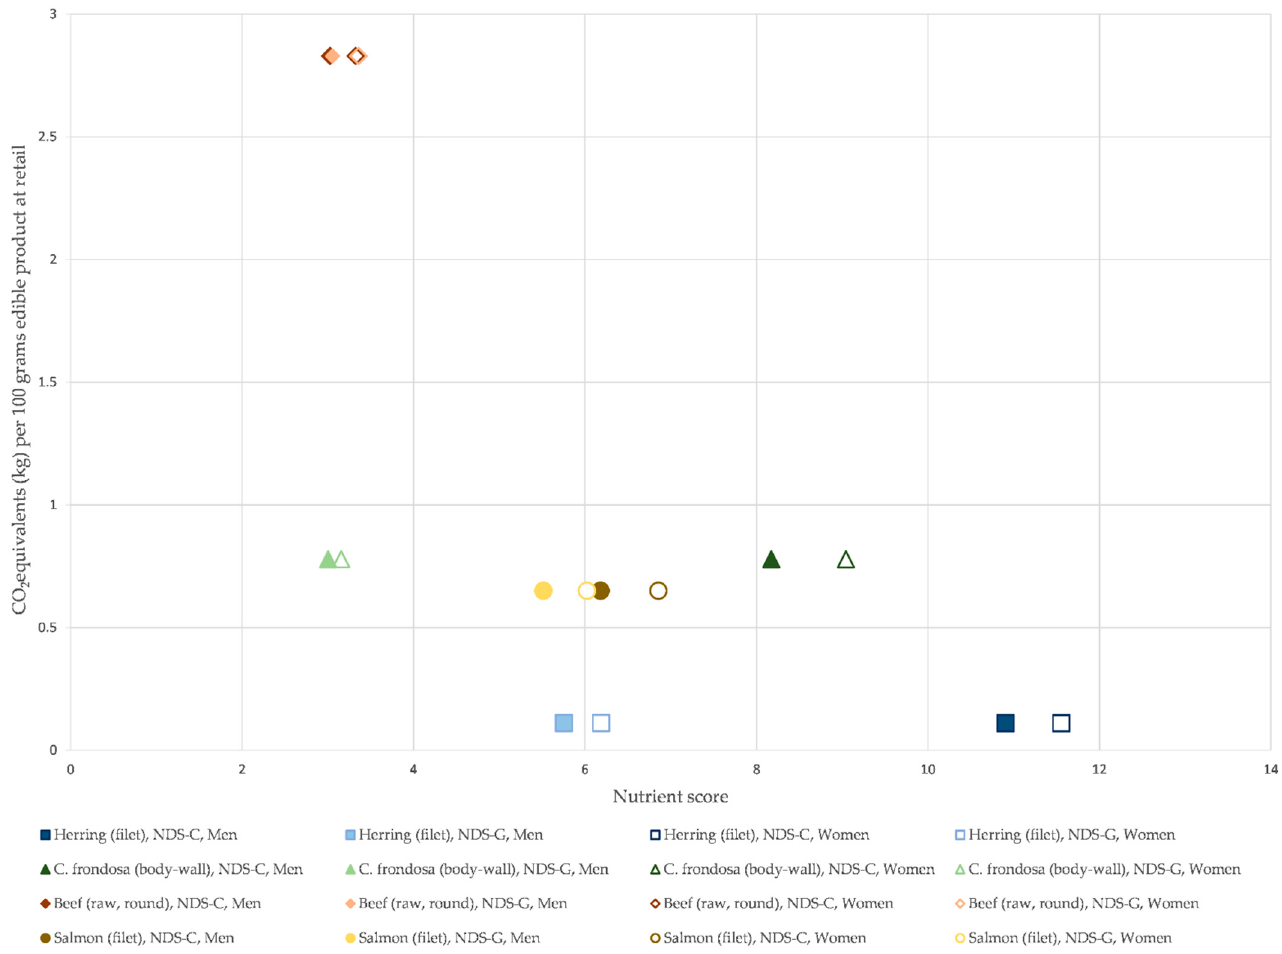
Figure 4. Nutrient density score (NDS) C and G, adapted from [21], for men and women aged 31–60 and compared with the carbon dioxide equivalent (CO 2 eq.) emissions between cradle (farm/fishery) and retail. CO 2 eq. emissions for herring ( Clupea harengus ) and salmon ( Salmo salar ) are adapted from [48], emissions for beef (Norwegian Red cattle (dual purpose cattle)) are adopted from [21,66], and emissions from orange-footed sea cucumber ( Cucumaria frondosa ) are from this article. NDS-C and G score food products according to their nutrient composition; however, NDS-G caps the score of nutrients which surpasses 100% of the daily recommended intake. The nutrients for herring, salmon and beef are adopted from [38] and shown in Table A2. Both the nutrient density score and the CO 2 eq. emissions are calculated per 100 g of edible